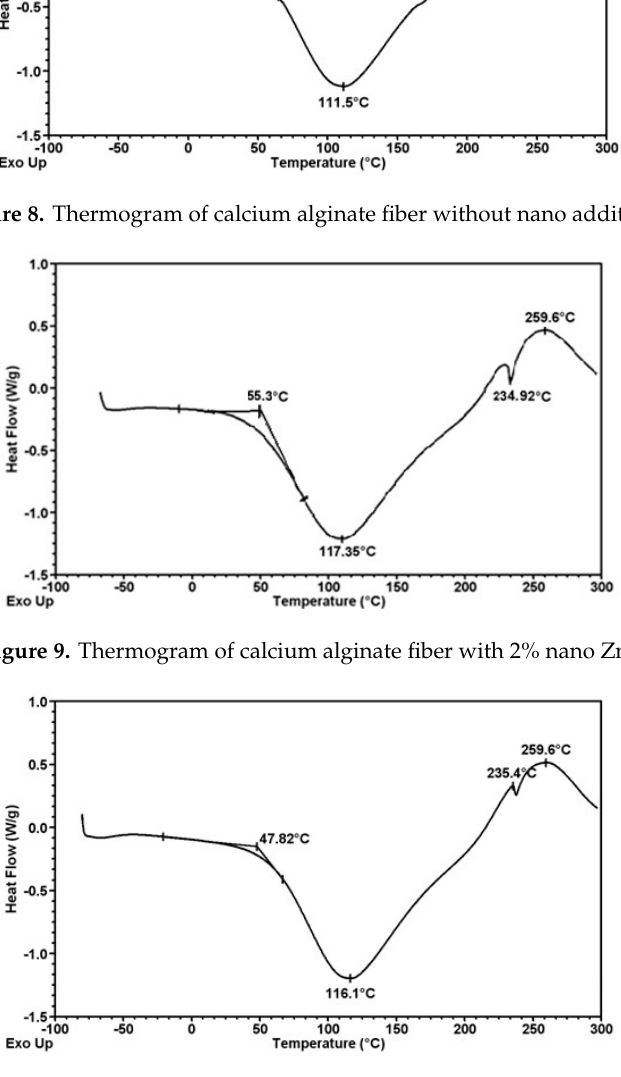
Figure 10. Thermogram of calcium alginate fiber with a 7% addition of titanium dioxide.